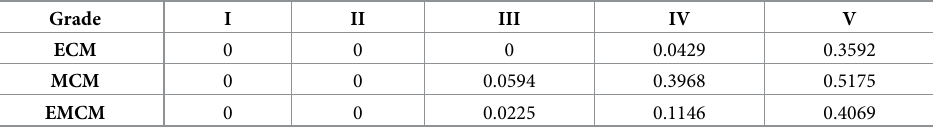
Table 6. Three similarity calculation methods calculate values.